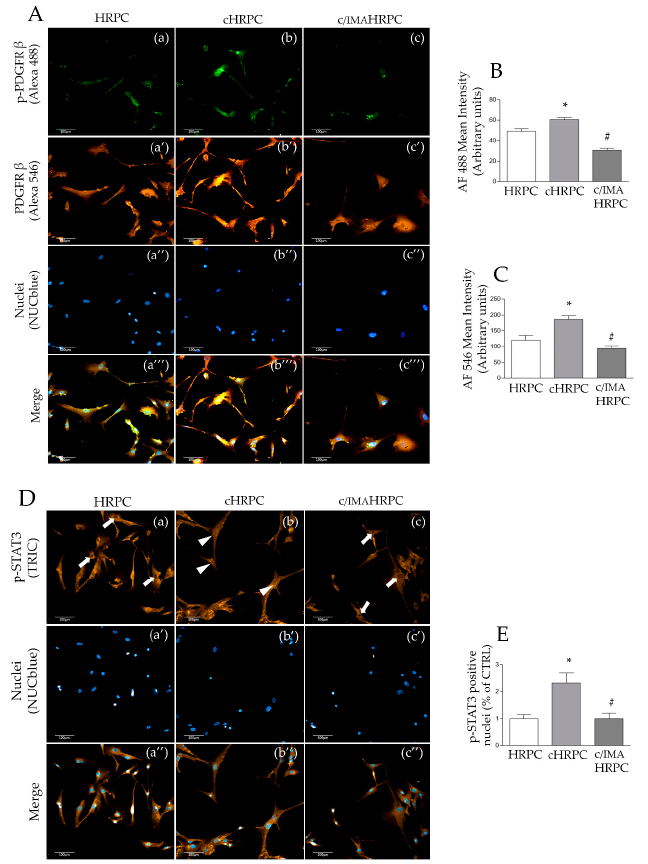
Figure 4. Immunocytochemical staining associated with high-content screening was used to analyze phospho-PDGFR β (p-PDGFR β ), total PDGFR β , and phospho-STAT3 (p-STAT3), in HRPC cultured alone (control, HRPC) or in the presence of 92.1UM (cHRPC) without or with 5 µ M of imatinib (c / IMAHRPC) for 6 days. ( A ): representative images of double immunocytochemical stained HRPC, cHRPC, and c / IMAHRPC for p-PDGFR β (in green; a , b , and c , respectively) and PDGFR β (in red; a” , b” , and c” , respectively). Moreover, relative NucBlue-stained nuclei ( a” , b’ , and c’ , respectively) and merged channels ( a”’ , b”’ , and c”’ , respectively) are shown. High-content screening analysis was used to quantify green fluorescence (Alexa Fluor 488) relative to p-PDGFR β staining ( B ) and red fluorescence (Alexa Fluor 546) relative to total PDGFR β staining ( C , D ): representative images relative to immunostaining for p-STAT3 (red) in HRPC, cHRPC, and c / IMAHRPC ( a , b, and c , respectively), the NucBlue-stained nuclei ( a’ , b’ , and c’ , respectively), and merged channels ( a” , b” , and c” , respectively). White arrowheads indicate p-STAT3-negative nuclei, whereas white arrows indicate p-STAT3-positive nuclei. ( E ): quantification of p-STAT3-positive nuclei in HRPC, cHRPC, and c / IMAHRPC carried out by high-content screening analysis (Section 4.7). All images were acquired with the Operetta High-Content Imaging System using a 20 × magnification; scale bar = 100 µ m. Data are expressed as media ± SEM from at least six fields / well randomly selected and each reporting more than 15 cells / field. All data represent mean ± SEM obtained from at least three independent experiments. * p < 0.05 vs. control (HRPC); # p < 0.05 vs. coculture conditions without imatinib. One-way ANOVA, followed by Tukey’s